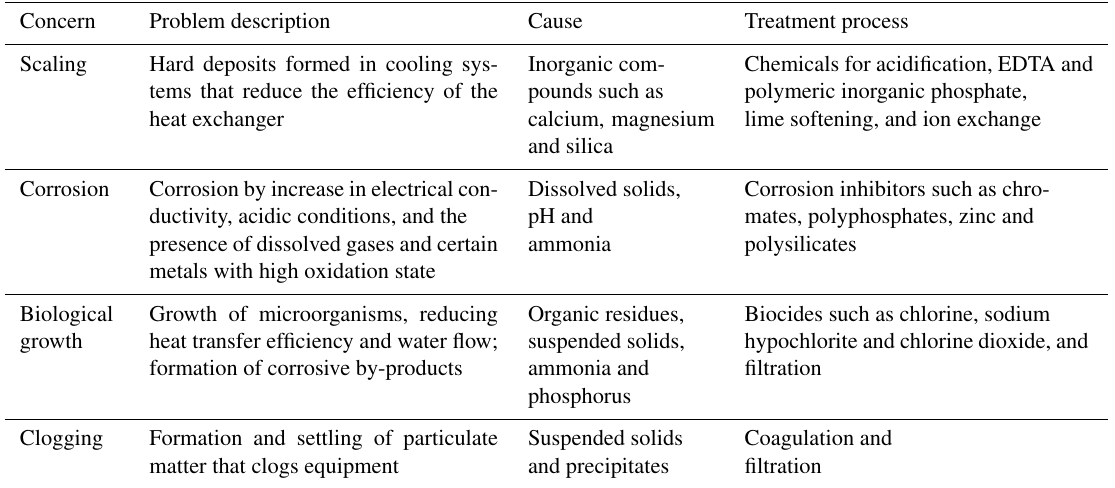
Table 3. Industrial water reclamation concern and potential treatment (sources: Asano, 1998; Cisneros, 2014; USEPA, 1992). Concern Problem description Cause Treatment process Scaling Hard deposits formed in cooling sys- Inorganic com- Chemicals for acidification, EDTA and tems that reduce the efficiency of the pounds such as polymeric inorganic phosphate, and silica Corrosion by increase in electrical con- ductivity, acidic conditions, and the presence of dissolved gases and